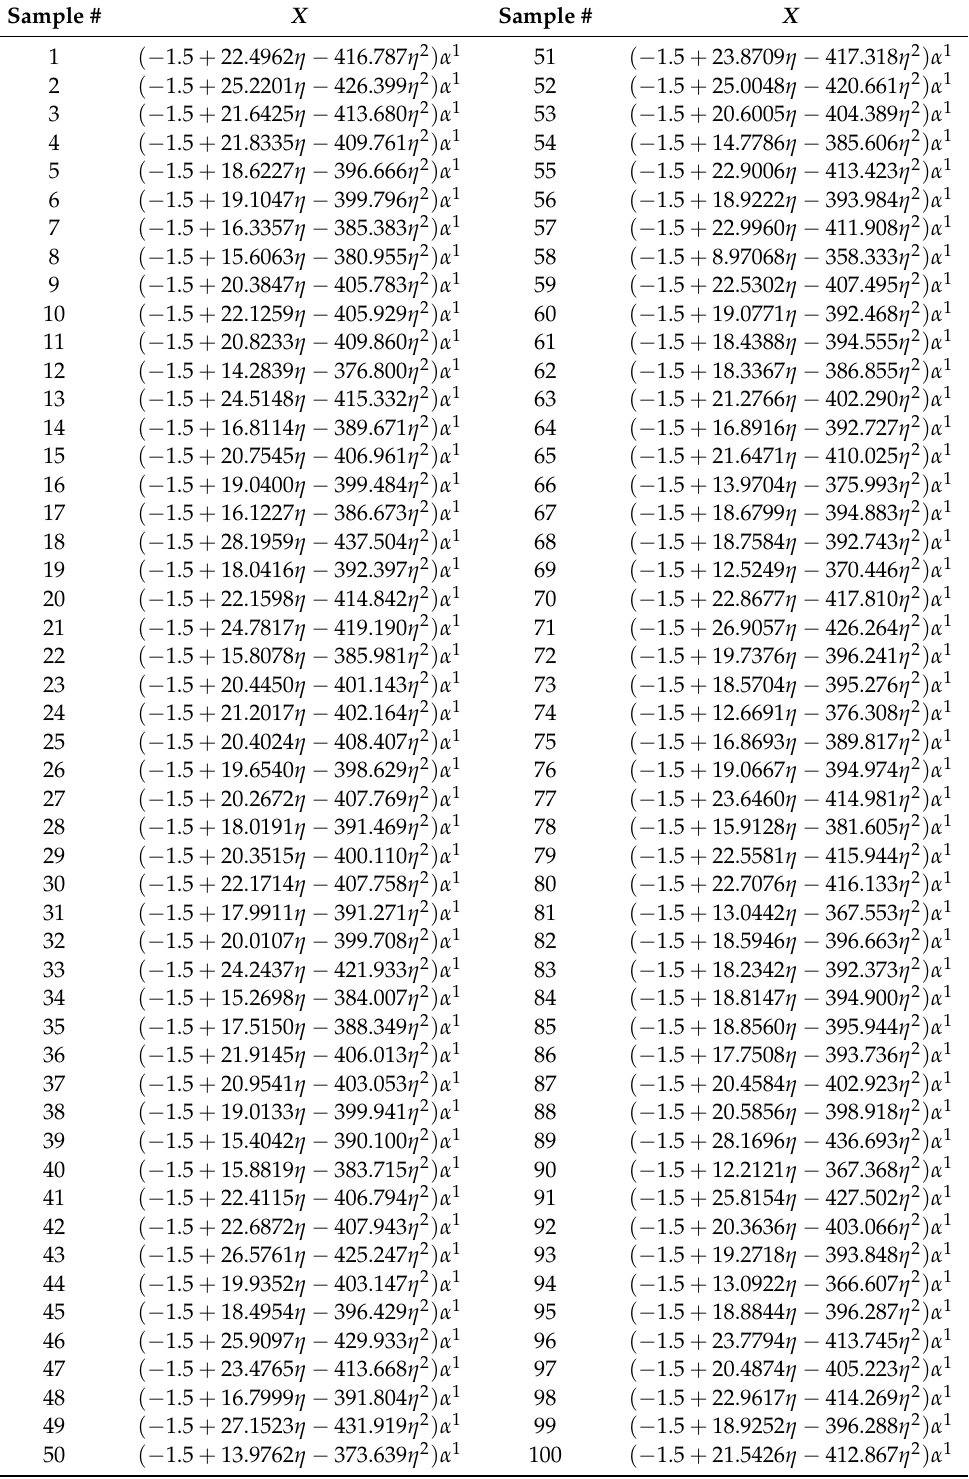
Table A1. Pseudo-random samples related to the Euclidean Gaussian considered in Section 5.2, and associated to Table 2, for the case 10 2 samples. We recall that its theoretical mean is ( − 1.5 + 20.33 η − 403.26 η 2 ) α 1 , its theoretical variance is ( 11.56 − 97.444 η − 768.853 η 2 ) , while the estimated mean is ( − 1.5 + 19.8637 η − 400.701 η 2 ) α 1 and its estimated variance is ( 13.7816 − 114.018 η + 246.011 η 2 )